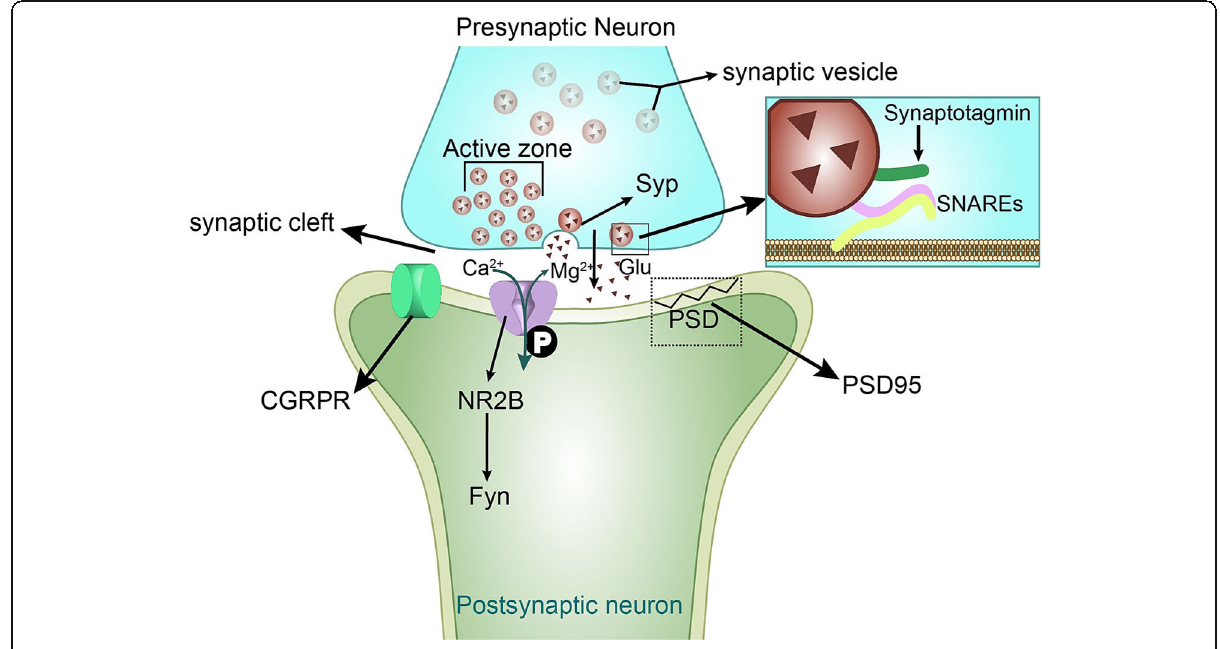
Fig. 9 Schematic diagrams of the NR2B-Tyr phosphorylation-mediated regulation of synaptic plasticity in central